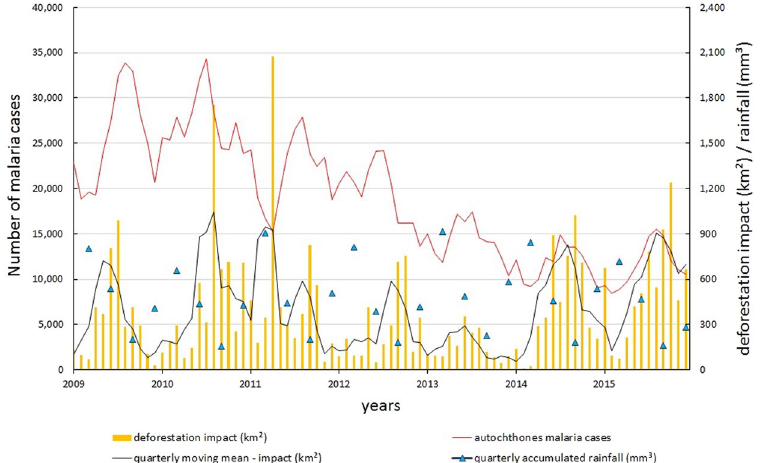
Figure 3. Distribution of number of cases of malaria, impacted areas of forest affected, quarterly moving mean of impacted deforestation and quarterly averages accumulated from 2009–2015 in Brazilian Amazonian States.